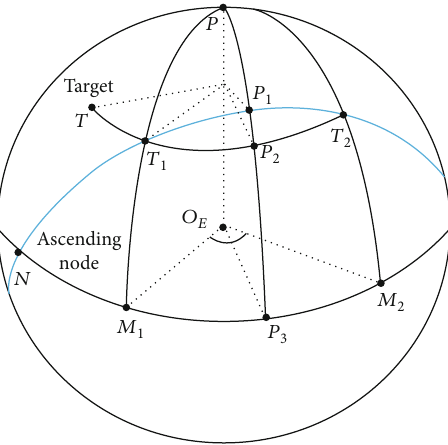
Figure 2: Monitoring during descending